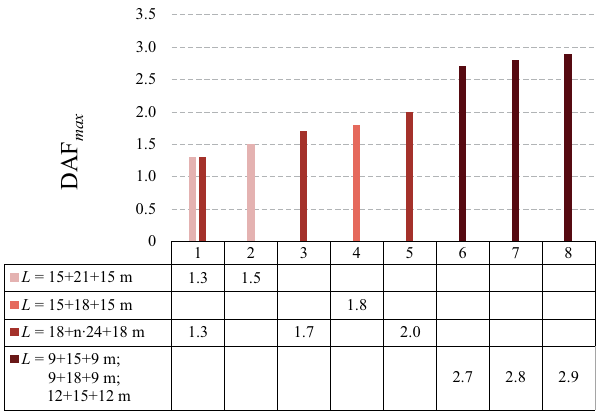
Figure 9. Multi-span continuous precast frame systems with trapezoidal cross-section beam size